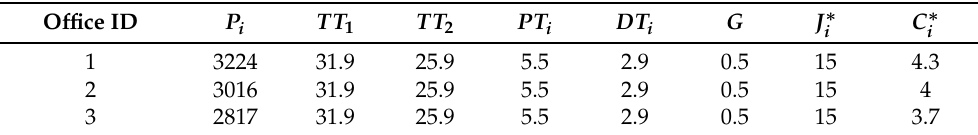
Figure 11. Convergence of the service time. Table 2. African Non Arab Countries Establishment shuttle bus service model input parameters and optimized outcomes (Times are in